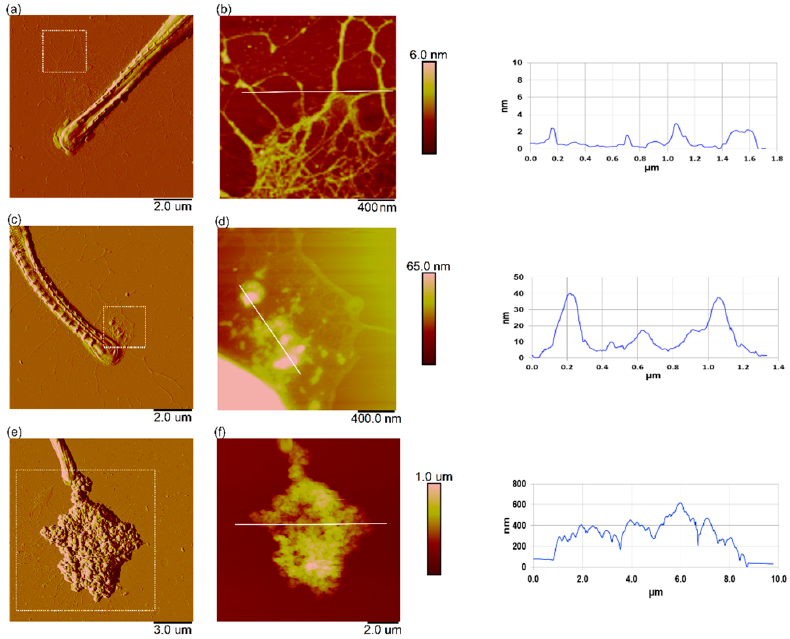
Figure 9. AFM images of a Cylindrotheca closterium cell exposed to PS-NH 2 and PS-COOH nanoplastics. An AFM deflection image ( a ) and 3D height image of the boxed area ( b ) of C. closterium exposed to PS-NH 2 (5 µ g mL − 1 ), with a vertical profile along the indicated line. Vertical profiles of nanoplastic particles along indicated lines in ( b , d ) are shown next to the corresponding image (line crossing particle in ( b ) and corresponding vertical profile is shown in the same color and indicated by the same number). The AFM deflection image ( c ) and 3D-height image of the boxed area ( d ) of C. closterium exposed to PS-COOH (200 µ g mL − 1 ), with a vertical profile along the indicated line. The images were acquired using the contact mode in air, with scan sizes of 5 µ m × 5 µ m ( a ), 3.5 µ m × 3.5 µ m, vertical scale 700 nm ( b ), 40 µ m × 40 µ m ( c ), and 8 µ m × 8 µ m, vertical scale 1.4 µ m ( d ).